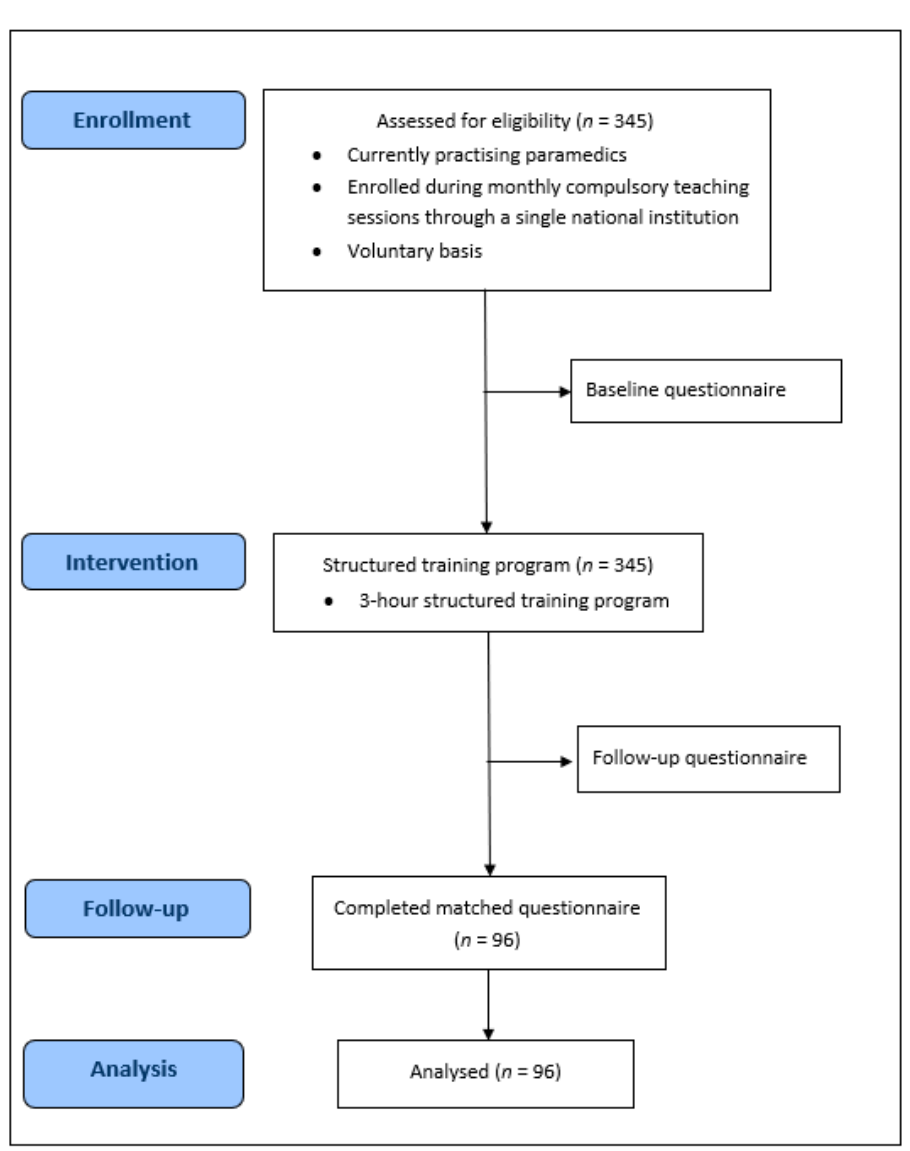
Figure 3. TOR study flow diagram.